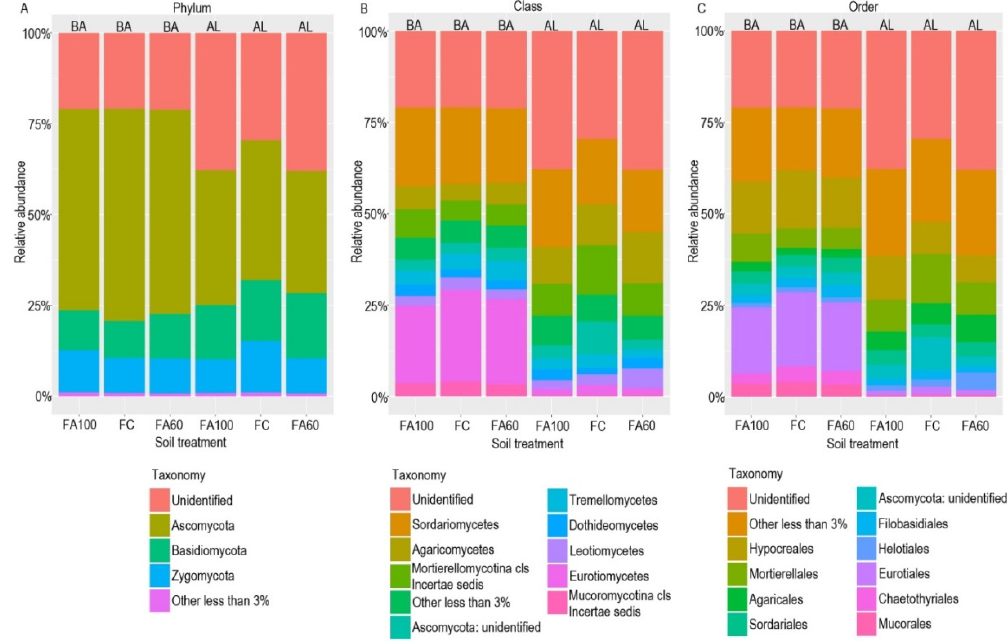
Figure 9. Distribution of fungal phyla ( A ), classes ( B ) and orders ( C ) obtained by next generation sequencing of DNA extracted from soil samples. Explanation: BA—Brunic Arenosol, AL—Abruptic Luvisol, FC—optimal dose of fertilizer, FA100—optimal dose of fertilizer enriched with microorganisms, FA60—fertilizer enriched with microorganisms (dose reduced by 40%).